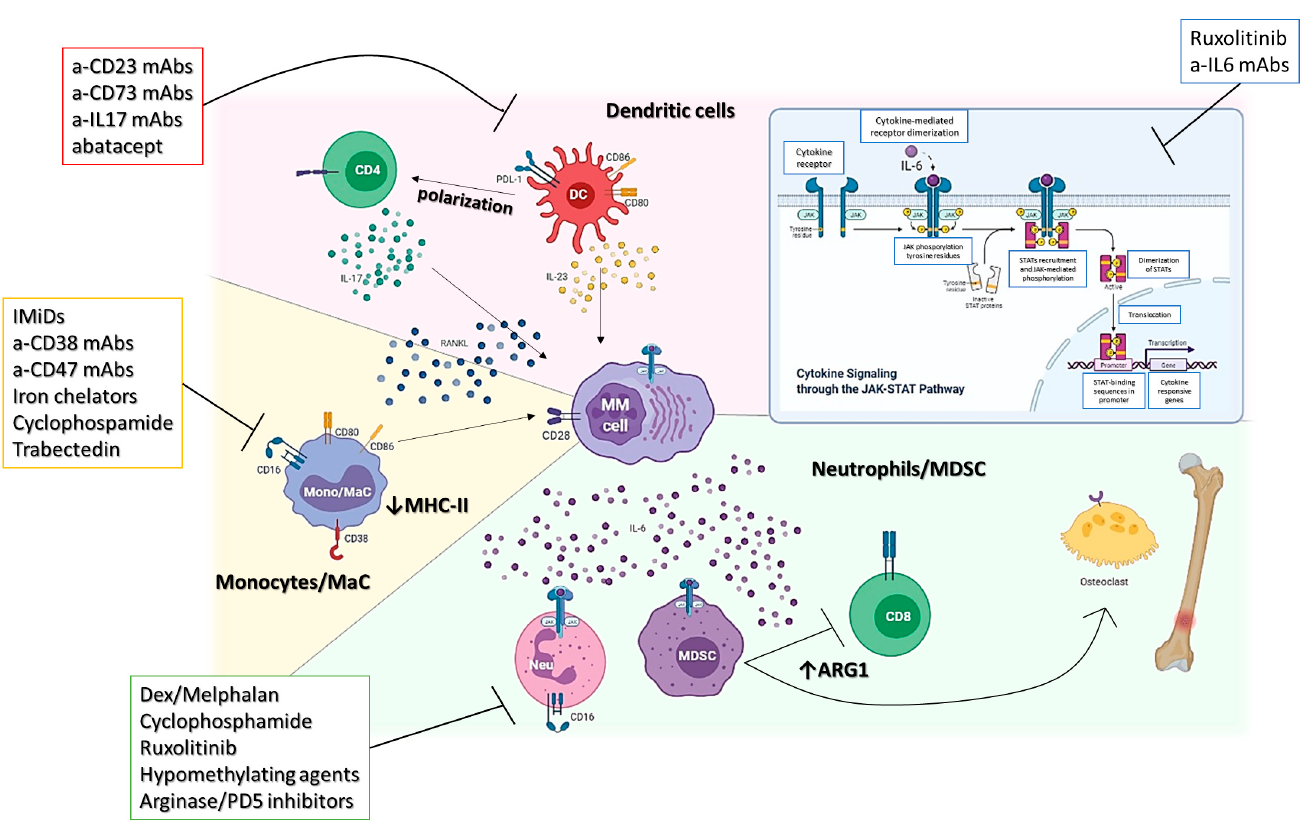
Figure 1. Role of myeloid cells in MM niche. Cartoon representing the main relationships among immune cells of myeloid origin and MM cells. Therapeutic opportunities are reported according to the pathways/cells they interact with.